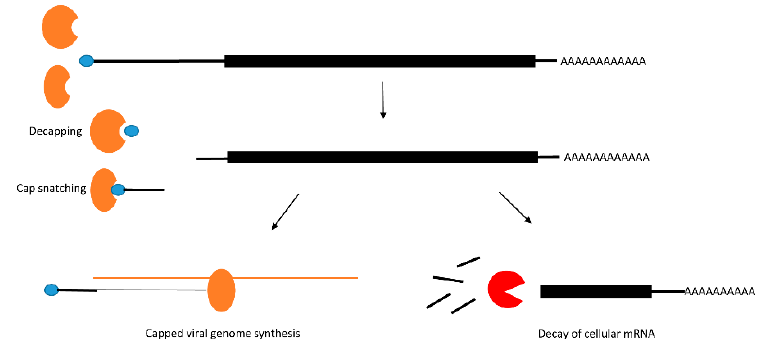
Figure 2. Decapping, cap snatching and cellular mRNA decay. In the case of VACV, the 5 ′ protective cap of the mRNA is removed by the viral decapping proteins (D9 or D10), which then allows for the host protein XRN1 to degrade the RNA. In Influenza virus, cap snatching by the PA protein initiates viral RNA synthesis that uses the removed cap as a primer leaving uncapped cellular mRNAs for degradation.